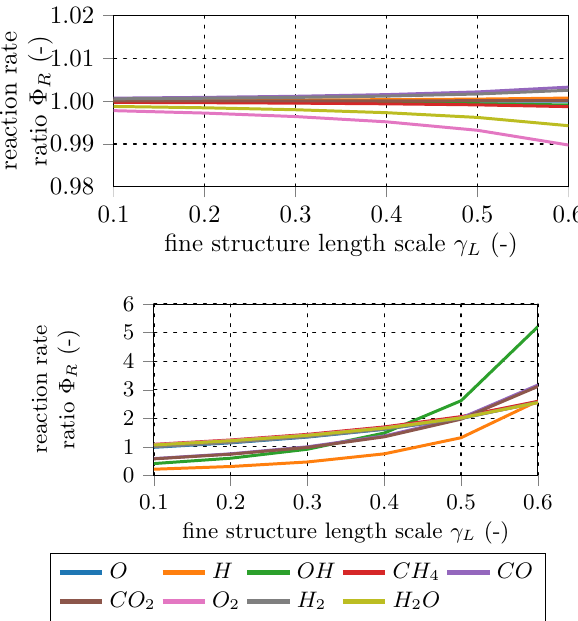
Figure 6. Comparison of the normalized PSR and PFR mean reaction rates for selected main species test cases. ( Top ): temperature 2000 K, stoichiometric mixture, fine structure residence time 1 s, ( Bottom ): temperature 1000 K, lean mixture, fine structure residence time 10 − 3 s.